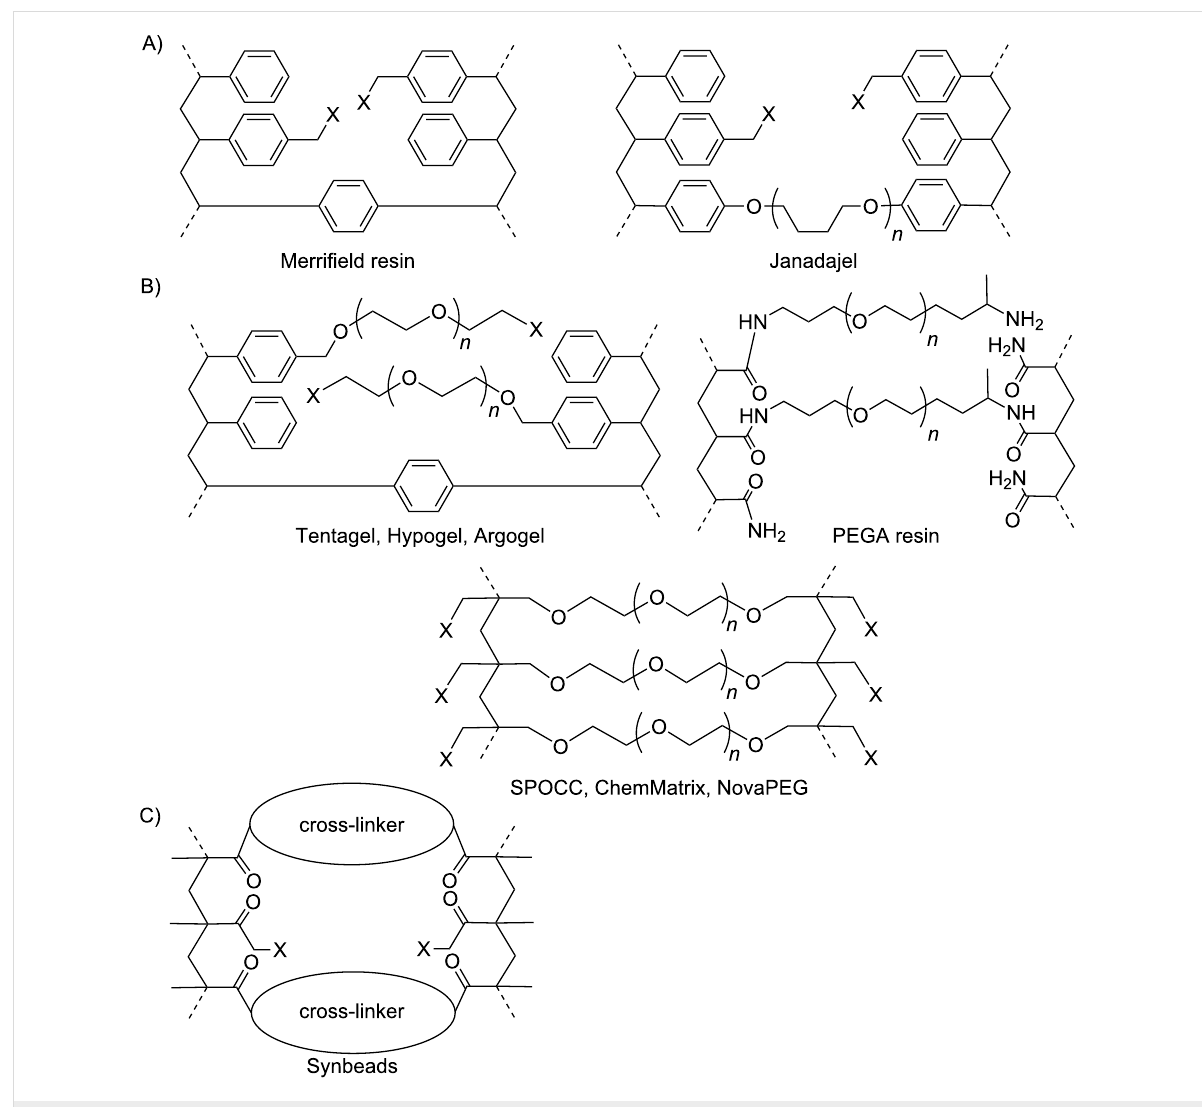
Figure 1: Different resins used for solid-phase synthesis. (A) Hydrophobic PS resins. (B) Water-compatible resins with PEG chains. (C) Nonswelling solid support compatible with aqueous reactions. X represents the functional groups, such as chlorides or amines.